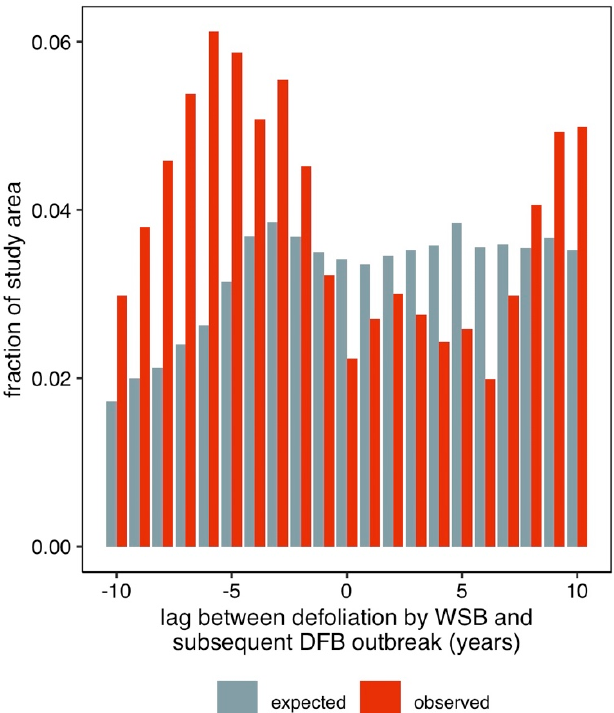
Figure A3. The observed and expected proportion of pixels affected by DFB and WSB by temporal lag for only pixels where the USFS Aerial Detection Surveys listed the Douglas-fir as the primary host and at least 25% (a four or more 240 × 240 m subpixel) listed presence of the agent. Here, − 5 signifies that WSB defoliation occurred 5 years prior to DFB presence. Red bars that exceed the height of grey bars indicate that spatiotemporal overlap of the two biotic agents occurs more often than expected due to chance at a given lag.